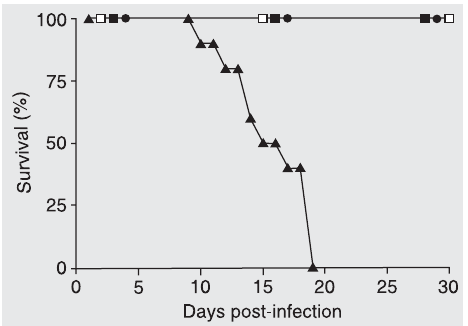
Figure 2. Mortality of BALB/c mice infected with sublethal doses of Tulahuen-2 trypomas- tigotes and treated with different iNOS inhibitors or a peroxyni- trite scavenger or not treated (open squares). Mercaptoeth- ylguanidine (filled squares), guanido-ethyl disulfide (circles), N G -nitro-L-arginine methyl ester (triangles). Five to 8 mice were used in each